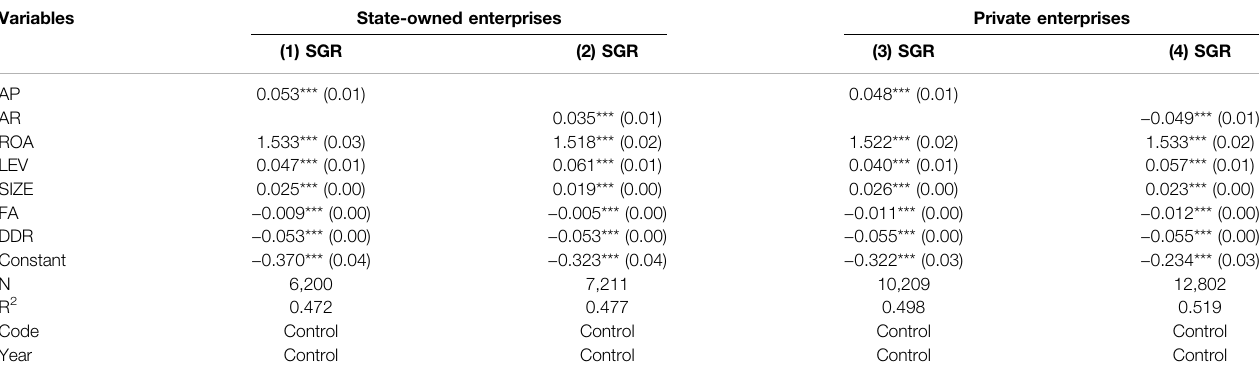
TABLE 7 | Heterogeneity analysis: Division of enterprise ownership.